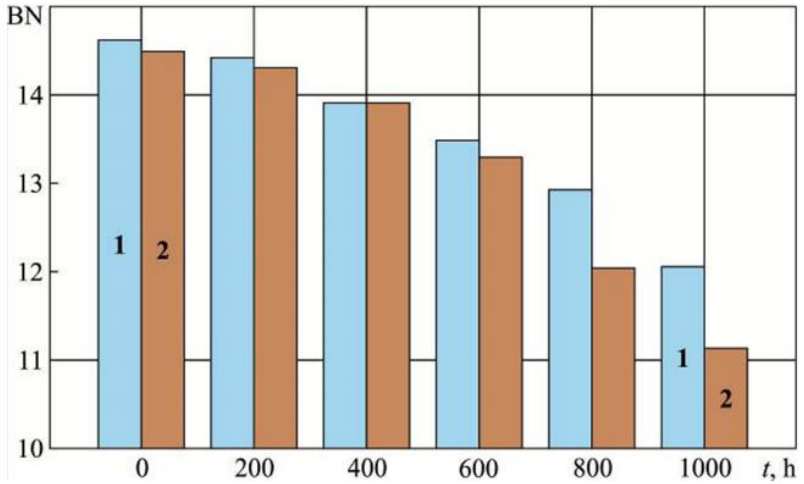
Figure 5. Oil BN change Shell Gadinia AL 40 under different experimental conditions: 1 — diesel AE 1; 2 — diesel AE 2.